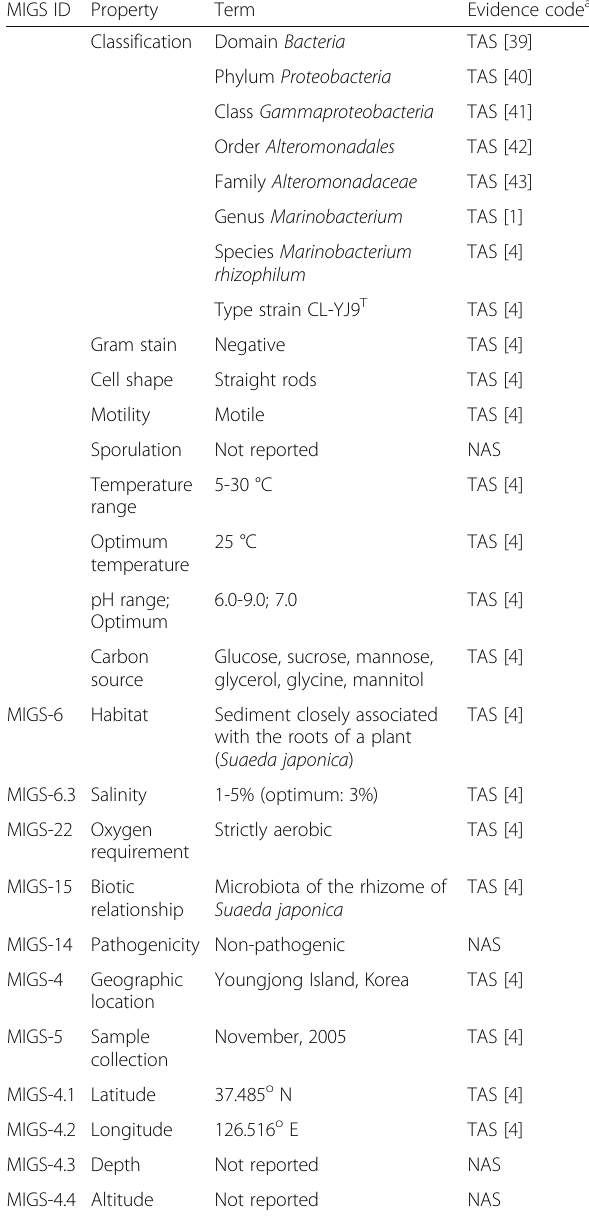
Table 1 Classification and general features of M. rhizophilum CL-YJ9 T [8, 9]